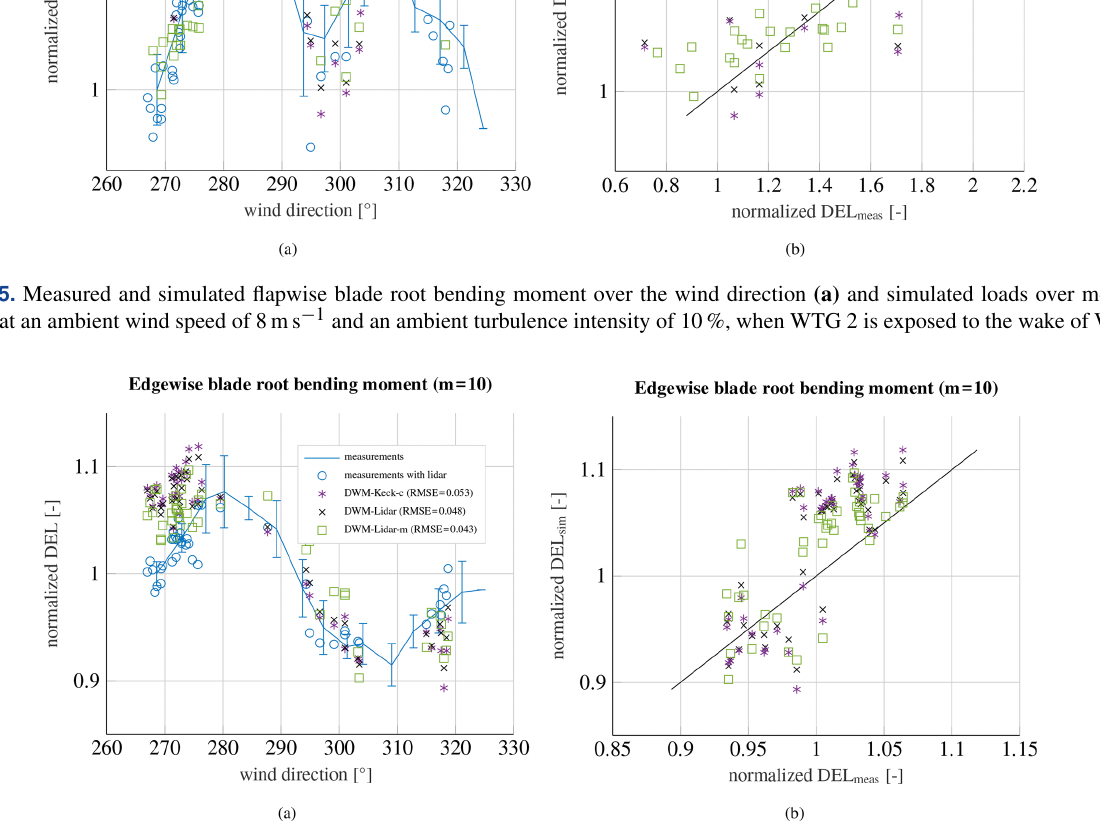
Figure 16. Measured and simulated edgewise blade root bending moment over the wind direction (a) and simulated loads over measured loads (b) at an ambient wind speed of 8ms − 1 and an ambient turbulence intensity of 10%, when WTG 2 is exposed to the wake of WTG